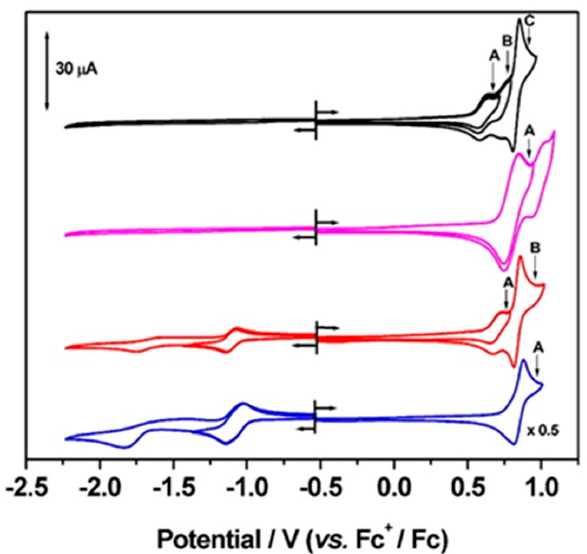
Figure 1. Cyclic voltammetry of P5A (black trace), [P5A-Rot] 2 + (magenta trace), P4A1Q (red trace) and P3A2Q (blue trace), in CH 2 Cl 2 containing [ n Bu 4 N][BF 4 ] (0.4 M) as supporting electrolyte, at ambient temperature and at 0.10 Vs − 1 . Letters indicate potentials applied in bulk electrolysis and spectroelectrochemical experiments; first oxidation ( A ), second oxidation ( B ) and third oxidation ( C ). Table 1. Cyclic voltammetric data a .